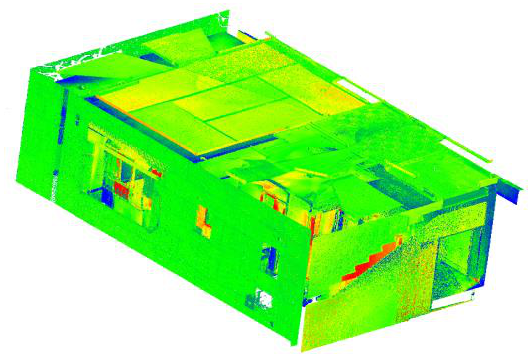
Figure 24. Original point cloud used for comparative evaluation.